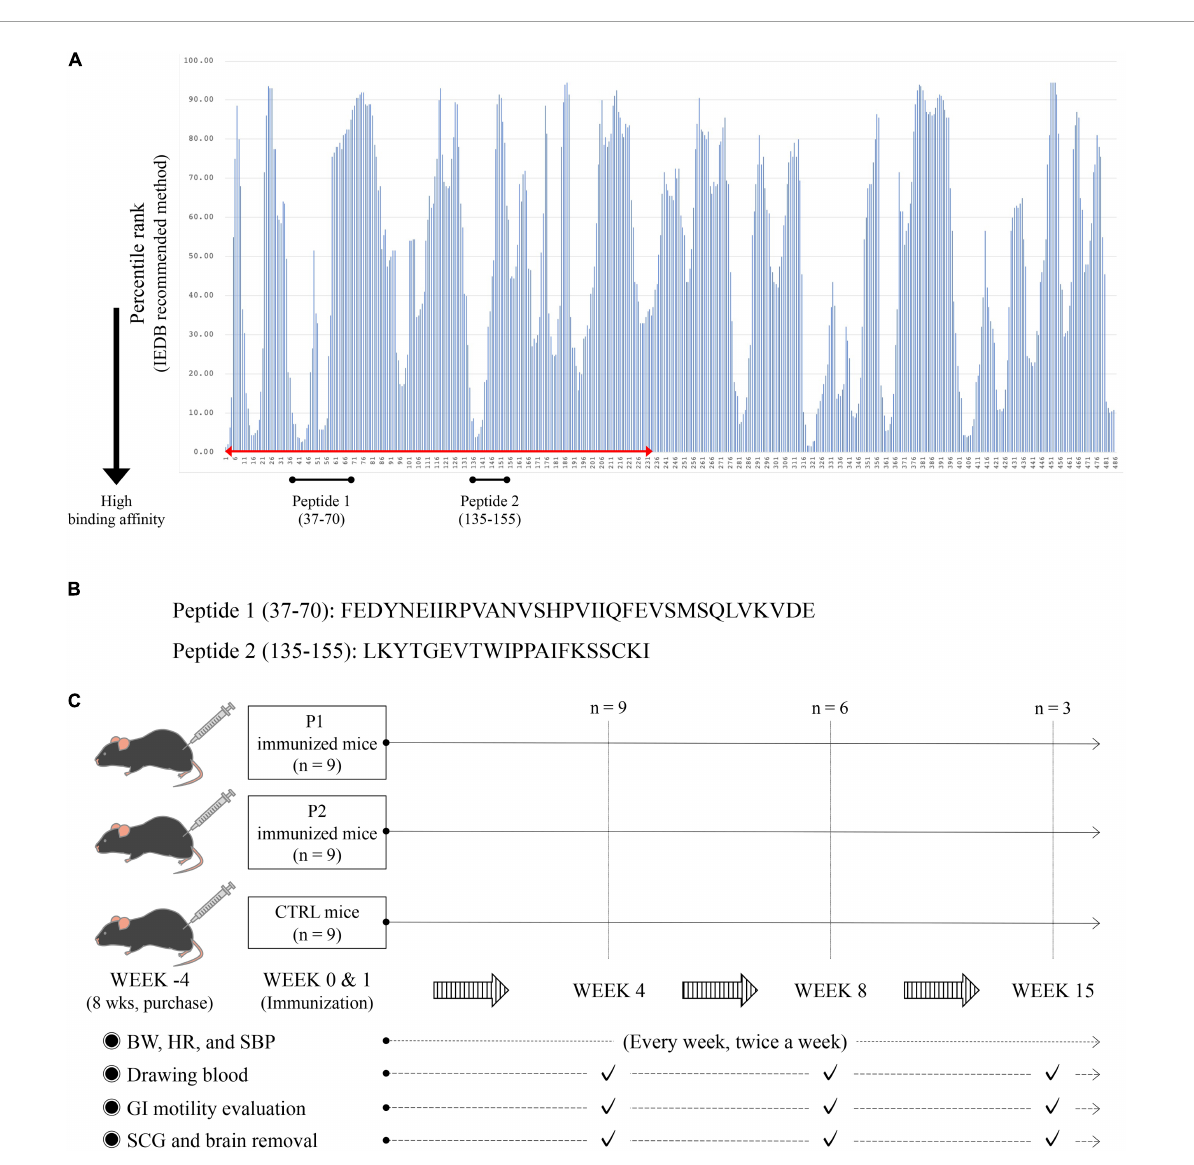
FIGURE1 MHC H-2-I binding mouse nAChR α 3 peptides predicted by immune epitope database (IEDB) analysis resource and research protocols. (A) The amino acid sequence of the mouse nAChR α 3 protein was analyzed using IEBD based on methods recommended by IEDB. Numbers on the horizontal axis indicate amino acid positions at the N-terminus of nAChR α 3-derived 15-mer peptides. Lower percentile rank numbers indicate stronger binding affinity to MHC H-2-I molecules. (B) The 34-mer long peptide with high percentile ranks for MHC H-2-I molecules was synthesized (Peptide 1, P1). The 21-mer long peptide with high percentile ranks for MHC H-2-I molecules was synthesized (Peptide 2, P2). (C) Twenty-seven mice (nine control mice with CFA only, nine nAChR α 3 P1 immunized mice, and nine nAChR α 3 P2 immunized mice) were used in this